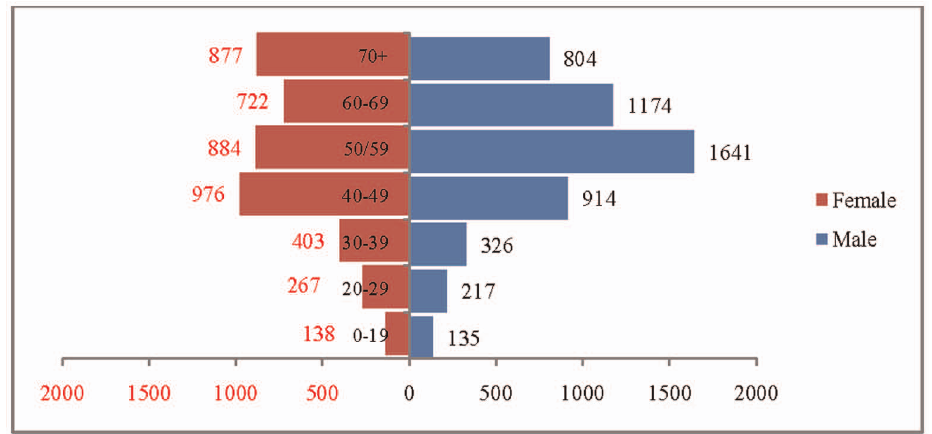
Figure 9. Estimated number of hospitalisation due to CVDs (in 000’s) by age and sex, India, 2016.